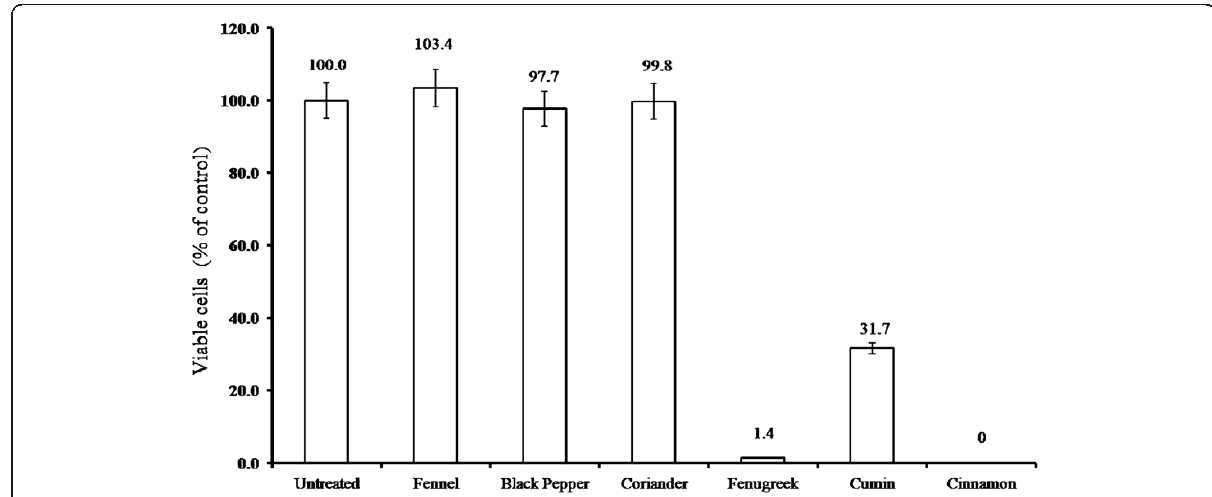
Figure 1 Effect of different spice extracts on viability of Jurkat cells. Jurkat cells were incubated with 1mg/mL of 50% ethanolic extracts of different spices for 72 hr. Viable cells were counted by trypan blue assay as described in methods. Fenugreek and cinnamon extracts were highly cytotoxic and affected the viability of most of the